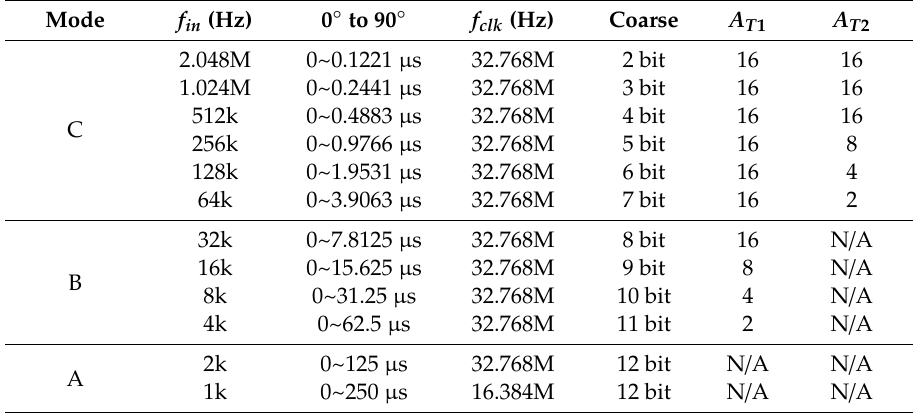
Table 2. Assignment of the interpolation factor for different operation modes and values of f in. Mode